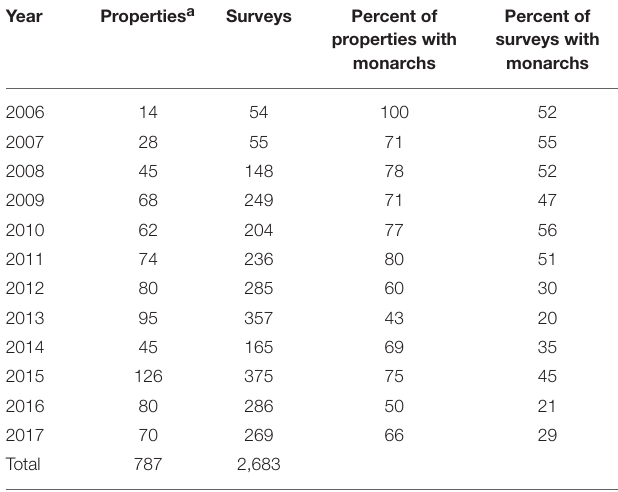
Percent of surveys with properties with monarchs